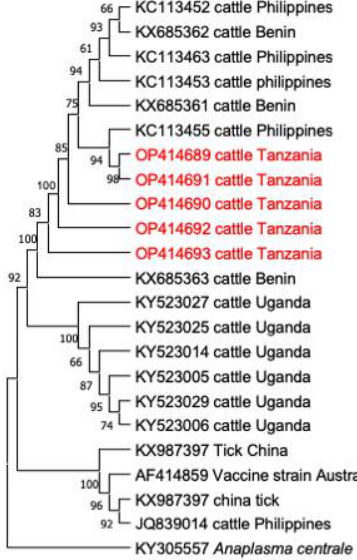
Figure 4. The phylogenetic analysis of Anaplasma marginale identified in this study, based on the ( groEL ) gene. The tree was constructed by MEGA version 11 using the maximum likelihood method, the confidence of occurrence of the nodes was assessed by bootstrap in 1000 replications. The sequences of this study are shown in red. Anaplasma centrale (KY305557) was used as an outgroup.